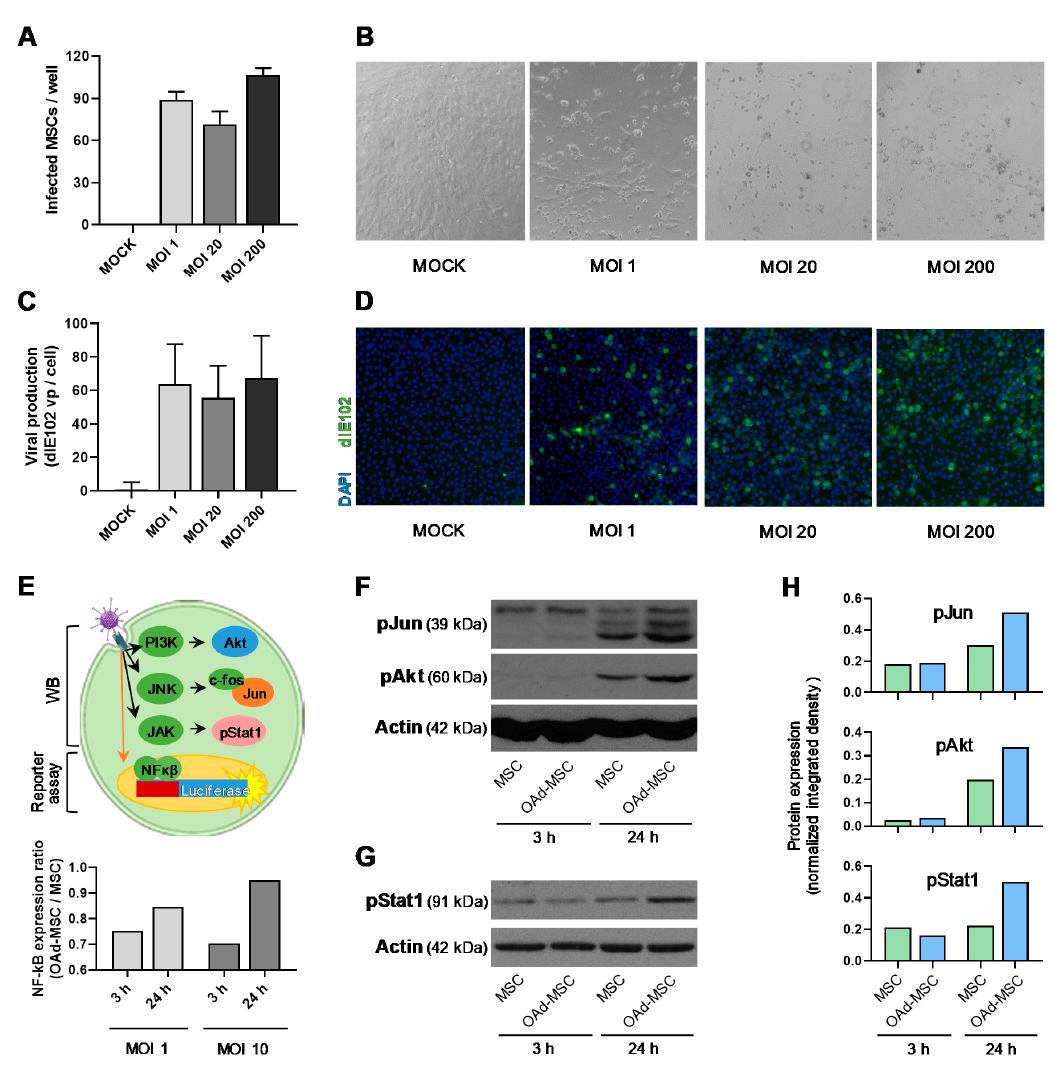
Figure 1. Viral production and signaling of mouse mesenchymal stem cells (MSCs) infected with dlE102. ( A ) Infected C57BL/6 MSCs per 96 wells, 48 h after infection with oncolytic adenovirus (OAd) dlE102 at multiplicities of infection (MOIs) 1, 20, and 200. Non-infected MSCs were used as a negative control (MOCK). ( B ) Representative images (20×) showing cytopathic effect in MSCs after infection with OAd dlE102 at MOIs 1, 20, and 200. ( C ) Viral production of MSCs infected with OAd dlE102 at MOIs 1, 20, and 200 (vp = viral particles). ( D ) Representative images (20×) showing adenoviral staining (green) in L929 cells cultured for 48 h with supernatants from infected MSCs. ( E ) Scheme showing the studied molecular signaling after adenoviral infection. Activation of Jun, Akt, and phospho-Stat1 (pStat1) is detected by Western blot (WB), while activation of the NF- κ B pathway is studied using a luciferase reporter system. Graph represents the NF- κ B activation at 3 and 24 h expressed as an OAd-MSC / MSC ratio. ( F , G ) Protein expression of phospho-Jun (pJun), phospho-Akt (pAkt), pStat1, and Actin analyzed by WB at 3 and 24 h after infection with dlE102. Mock-infected MSCs were used as a control. Complete WB images can be found in Figures S3–S7. ( H ) Quantification of protein expression of pJun, pAkt, and pStat1 expressed as integrated density normalized to loading